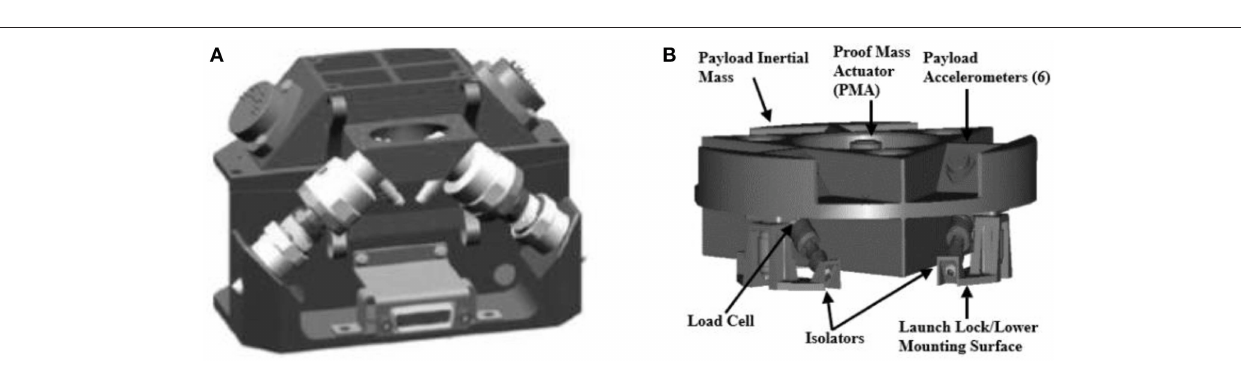
horizontal or vertical isolation, while the shocking effect after the combination of horizontal and vertical motion and the uplifting action caused by the swing of superstructure are less involved. Additionally, the existing multi-dimensional mitigation and isolation devices commonly adopt different combinations of springs and a variety of dampers. Few devices utilize